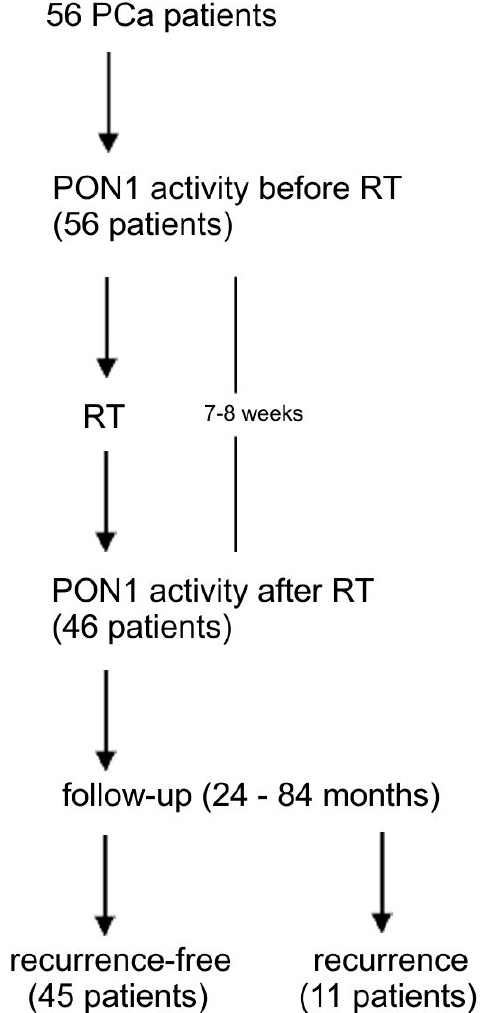
Figure 1. The schematic design of the study. PCa-prostate cancer, PON1-paraoxonase-1,